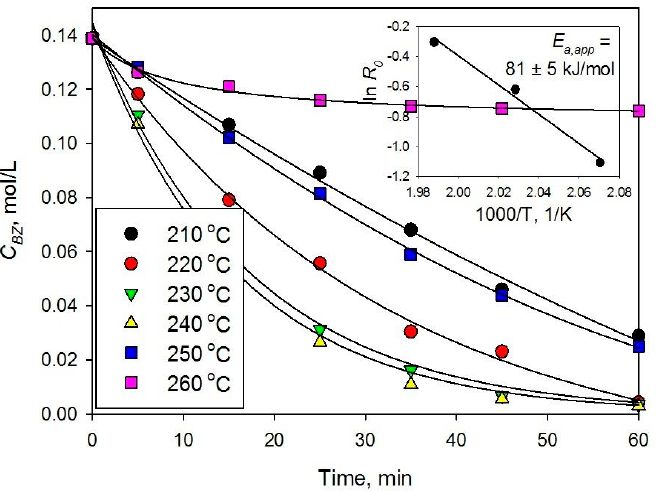
Figure 2. Effect of temperature on hydrogenation of BZ to CH over 1% Pt/HPS (5 MPa, catalyst loading 100 mg); inset shows the Arrhenius plot for initial reaction rate, R 0